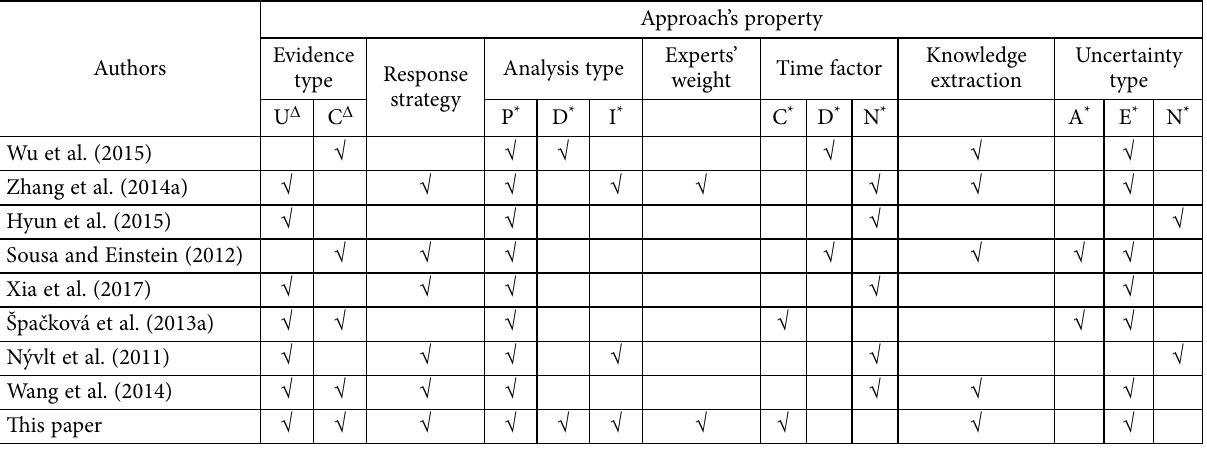
Table 1. Comparison of properties of some risk-informed decision support approaches for tunnel construction.